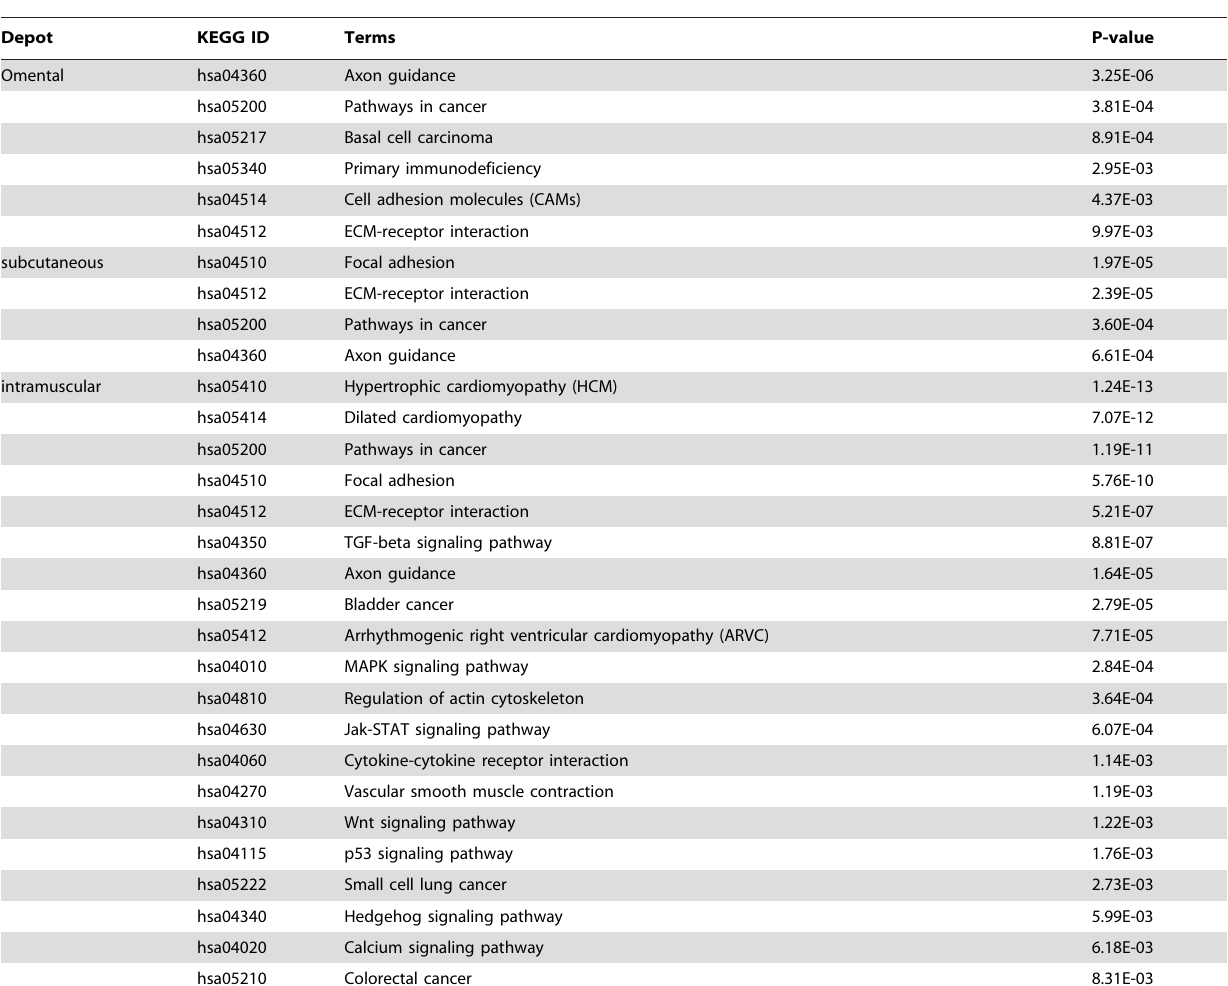
Table 3. KEGG pathways of DEGs involved in developmental